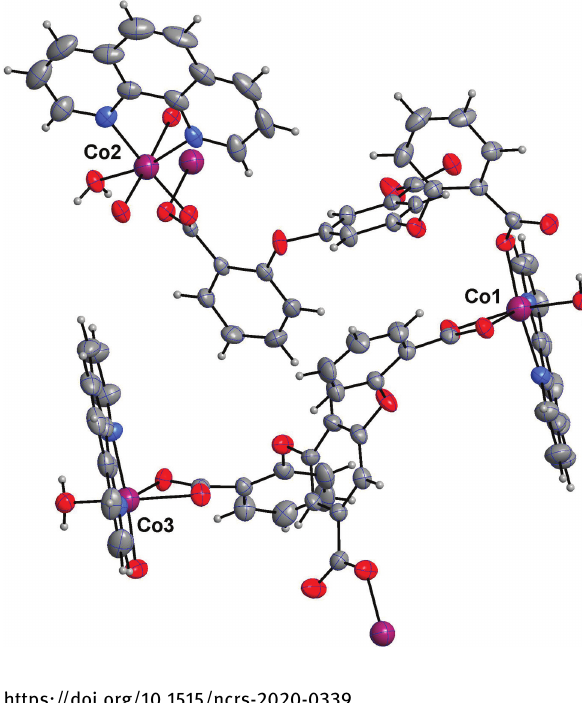
Table 1: Data collection and handling.